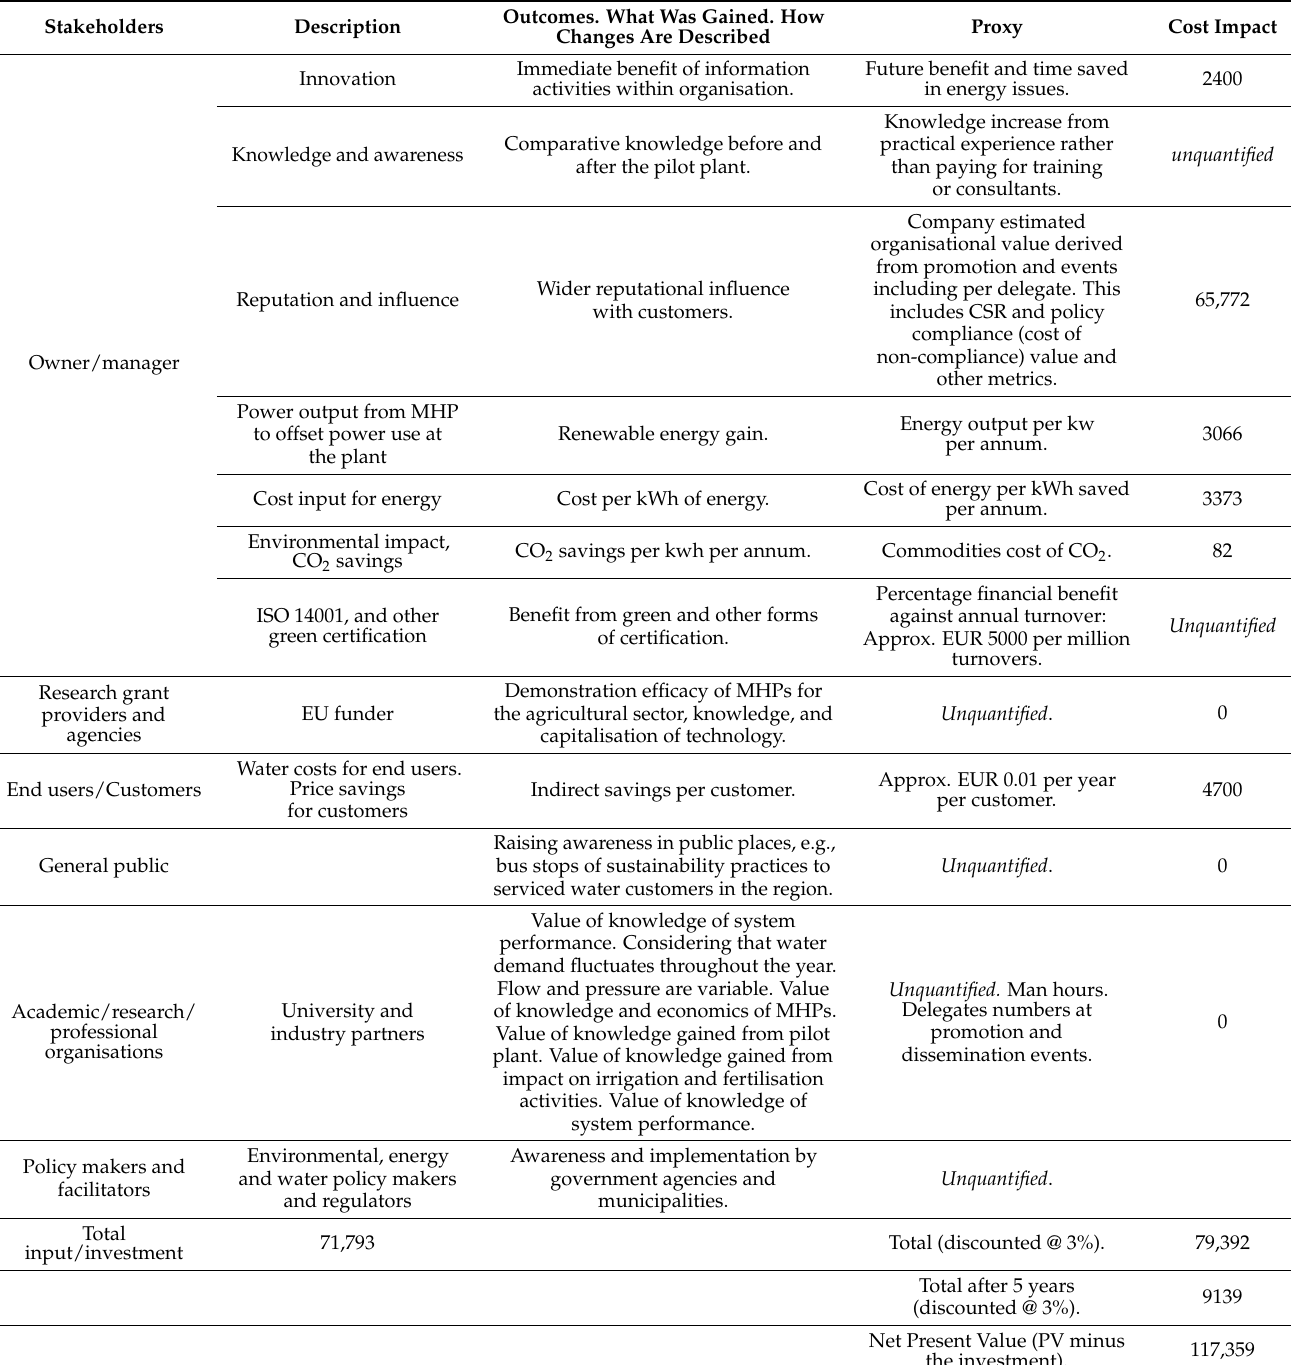
Table 4. Estimating SROI for the French demonstrator. Cost impact estimates, quantity times, financial proxy, less deadweight, displacement, and attribution. All values to nearest